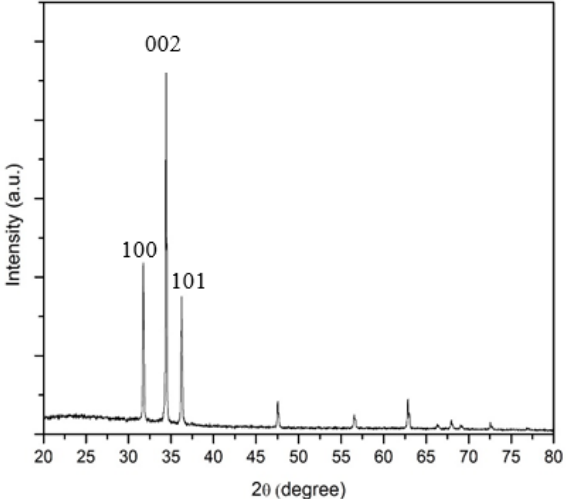
Figure 4. X-ray di ff raction (XRD) pattern of ZnO nanorods on Zn-hexamethylenetetramine (HMTA) Figure 4. X-ray diffraction (XRD) pattern of ZnO nanorods on Zn-hexamethylenetetramine (HMTA) seed seed layer.